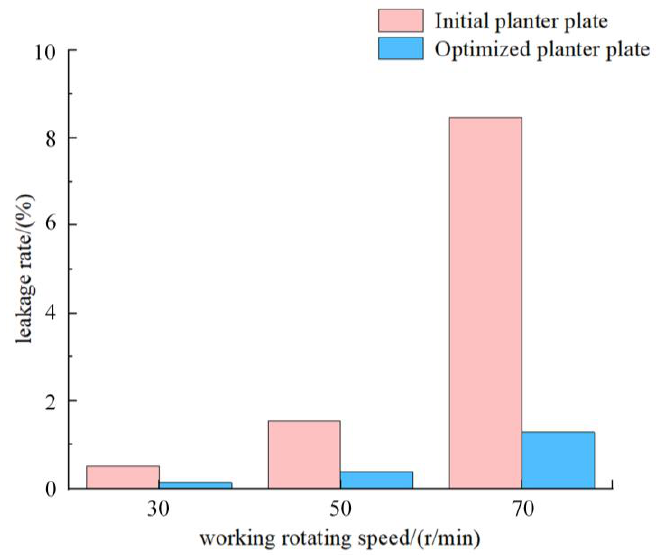
Figure 18. Comparison of seed filling performance between an initial planter plate and an optimized planter plate.